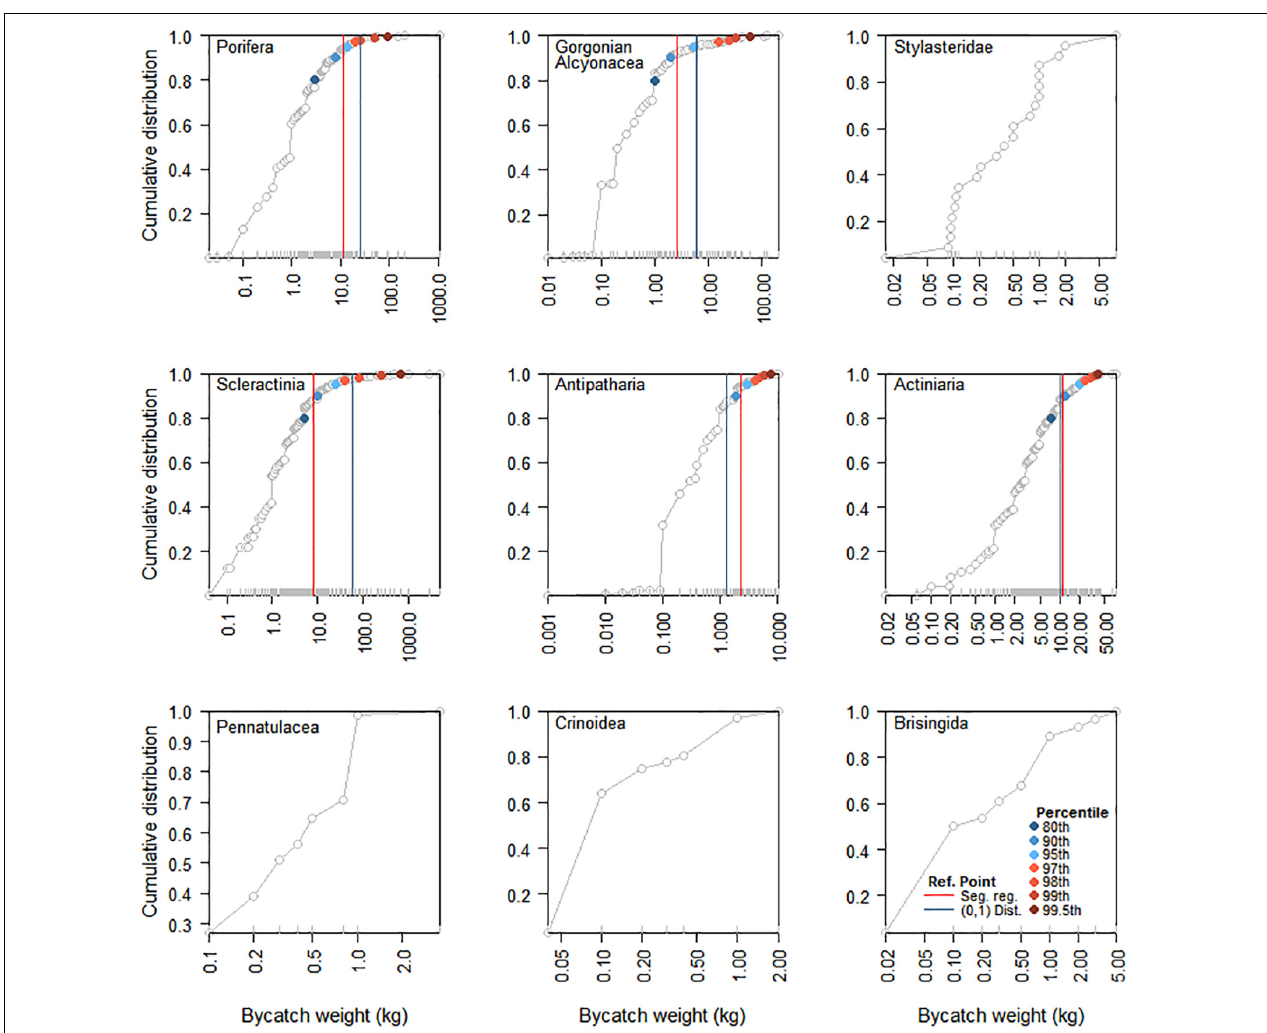
FIGURE 5 | Cumulative distributions of bycatch weight (kg) of VME indicator taxa in New Zealand bottom trawls within the SPRFMO Convention Area as reported by observers for the 2008–2018 period. Percentiles and naturally occurring or ecologically relevant reference points calculated using 3-parameter segmented regressions and the (0,1) distance are shown for the five taxa with sample sizes large enough to calculate the 99.5th percentile. Note that the x -axis is on the log-scale, and the limits of the x-axis differ between